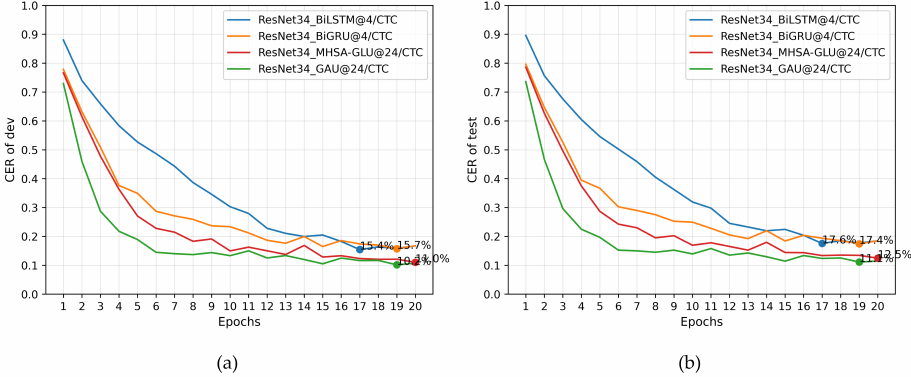
Figure 11. Pre-training CER of different models. ( a ) CER of expanded Aishell corpus for dev. ( b ) CER of expanded Aishell corpus for test.